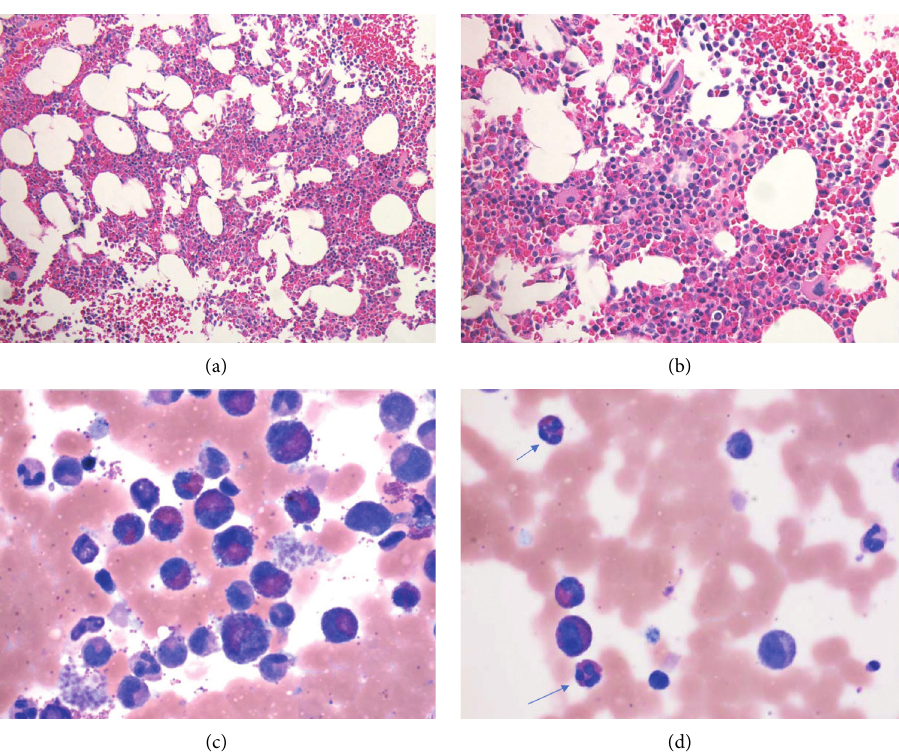
Figure 1: Bone marrow biopsy in a 17-year-old female with no significant past medical history. (a) H&E (400X magnification) section of the bone marrow biopsy, with trilineage hematopoiesis and a significant increase in eosinophils. (b) H&E (400X magnification) section of the bone marrow biopsy. (c), (d) Aspirate at high power (1000X magnification) showing an increase in mature eosinophils with occasional trilobed nuclei (arrow) and no increase in